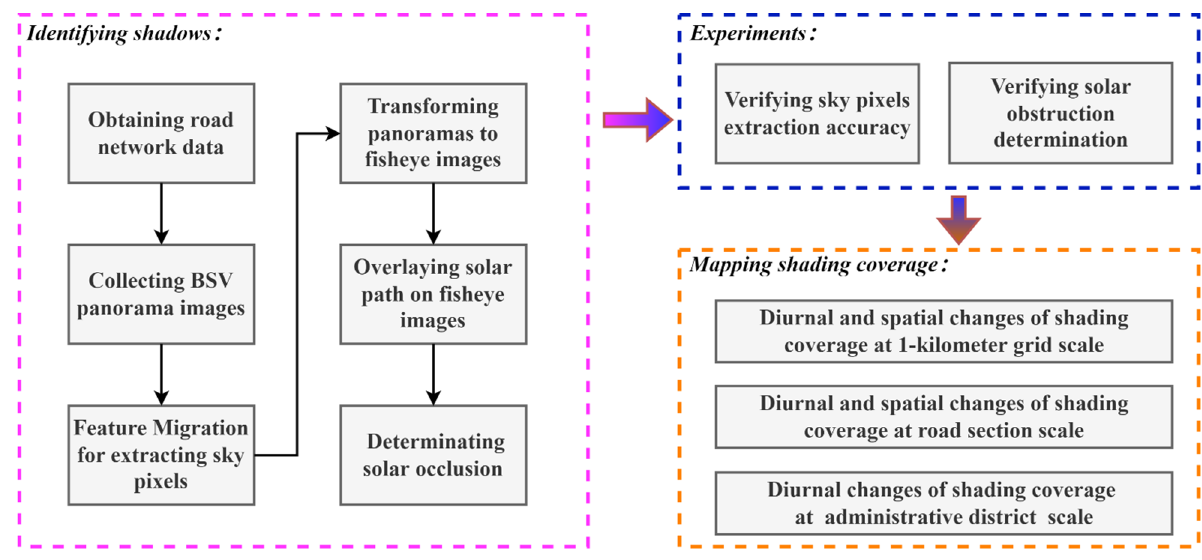
Figure 2. Schematic framework of this study.